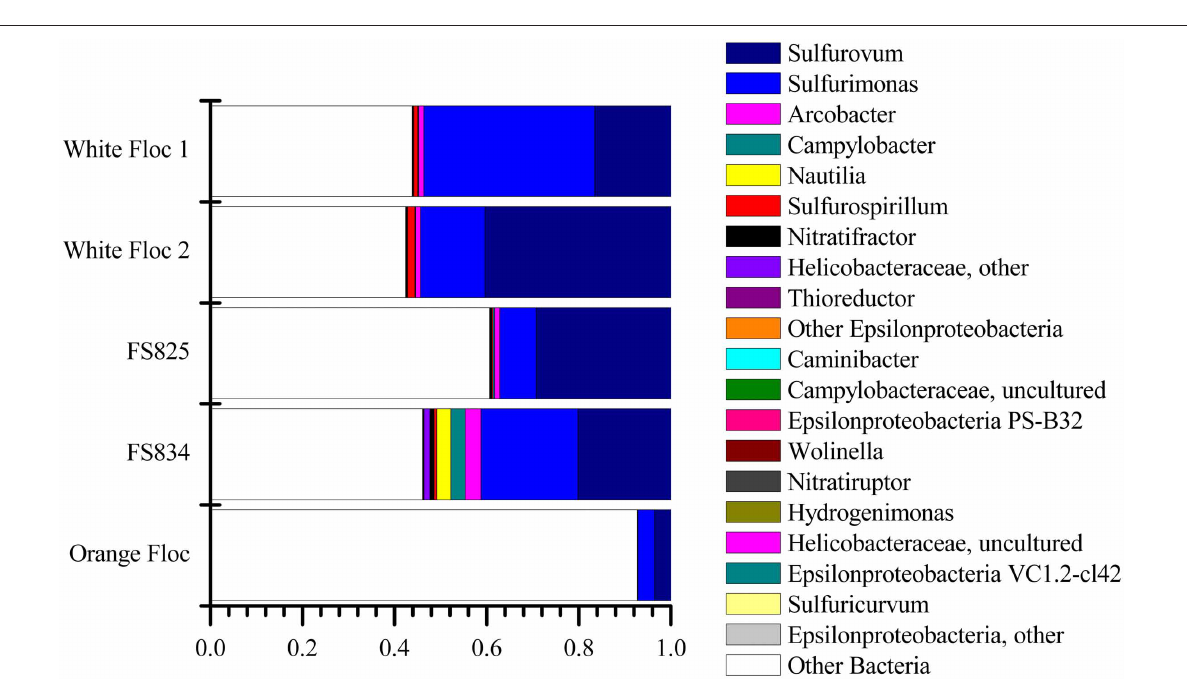
fluid or floc sample was Sideroxydans , which constituted